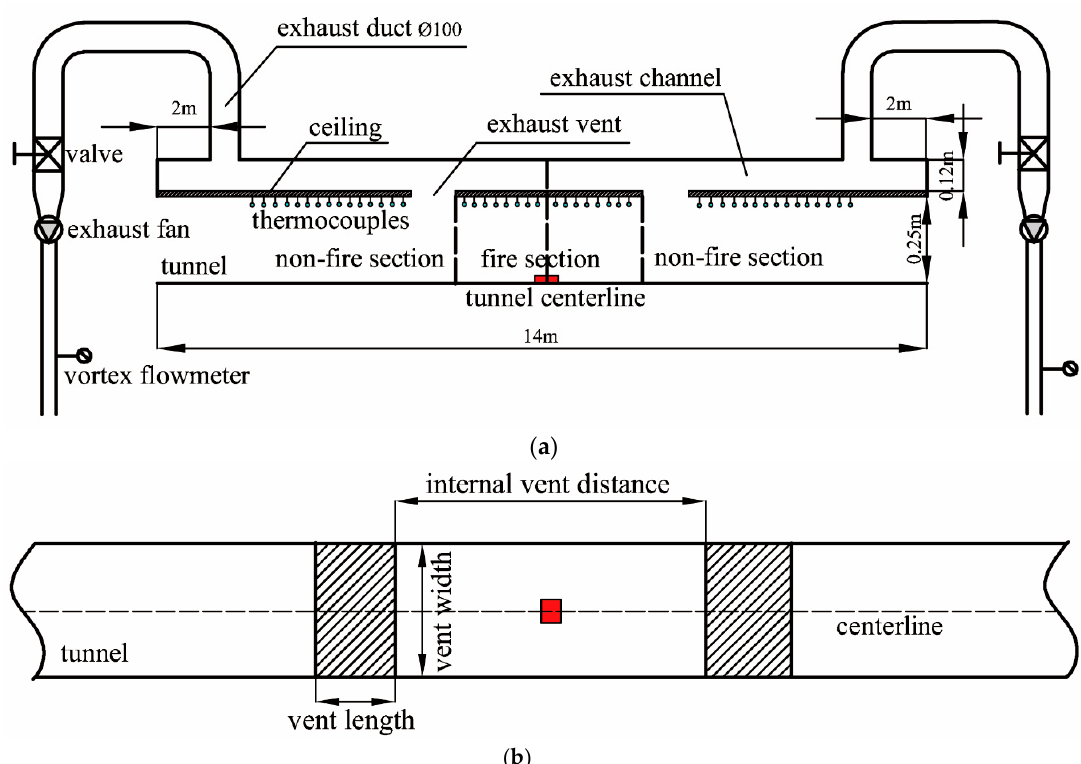
Figure 4. Model tunnel system.